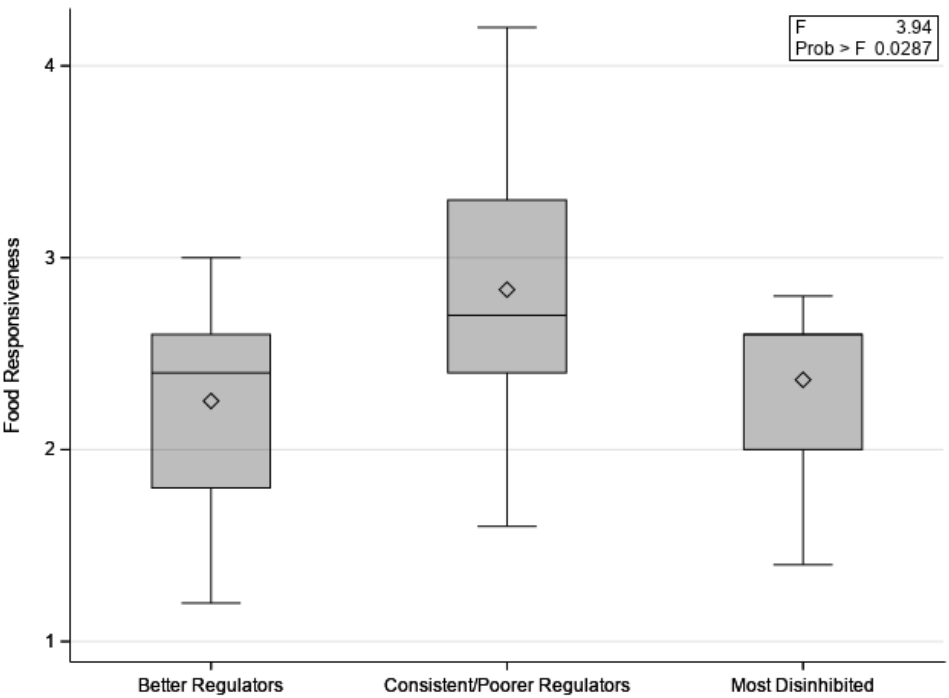
Figure 4. Means of children’s food responsiveness for “Better Regulators” ( n = 15), “Consistent/Poorer Regulators” ( n = 12), and “Most Disinhibited” ( n = 11) groups. Table 1. Results examining associations between children’s candy intake group with temperament and appetite.